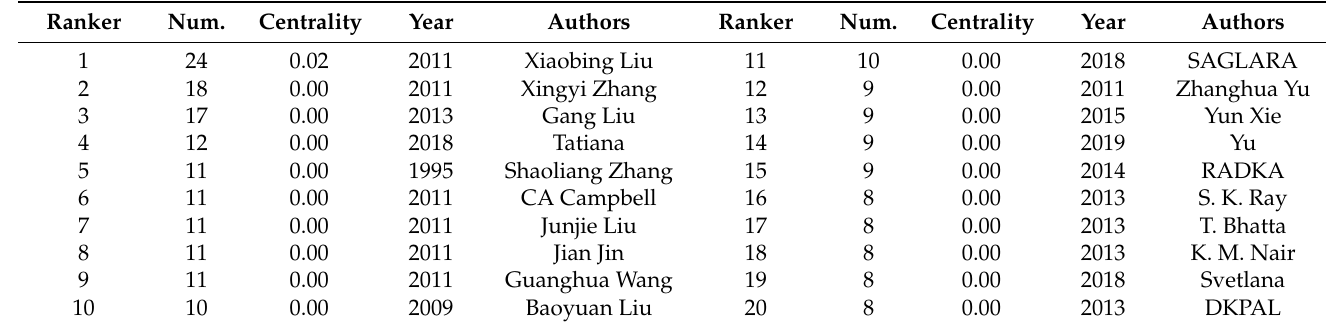
Table 1. Information on the top 20 authors in terms of number of